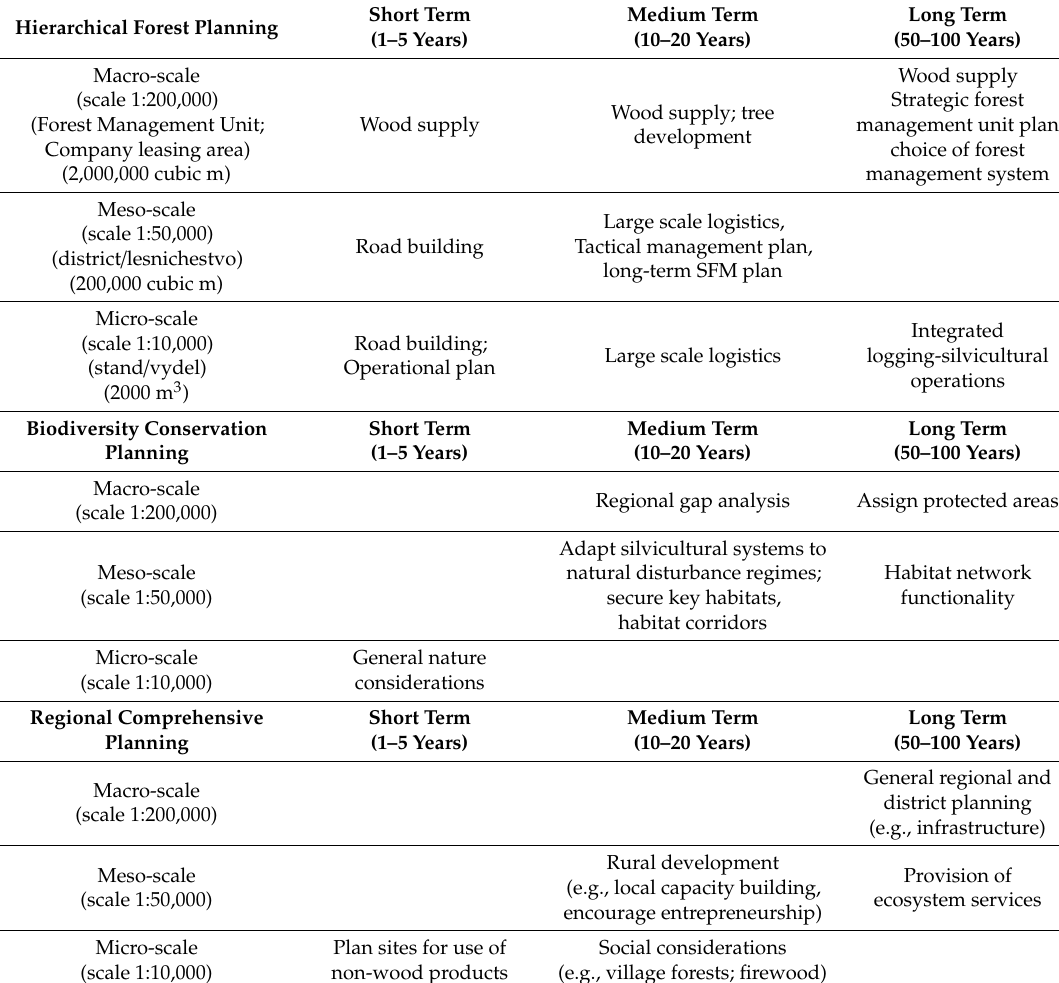
Table 5. Outline of how di ff erent planning dimensions can be framed using planning horizons (short-term to long-term) across multiple spatial scales for: (a) hierarchical forest planning of wood supply–roads–logging–silviculture; (b) securing ecological dimensions through biodiversity conservation planning, including ecosystem services; and (c) to satisfy socio-cultural dimensions, based on regional comprehensive